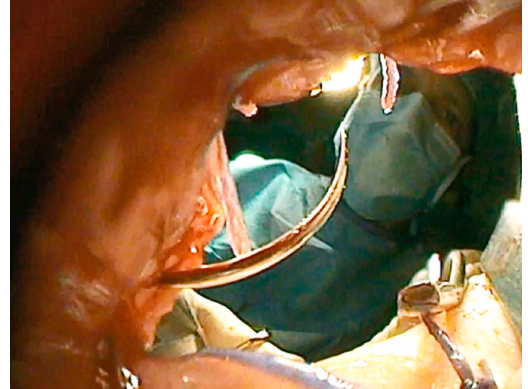
Figure 4. Screenshot of Video S2. Trans-neoanal endoscopic view of the anastomosis being con-structed. Figure 4 . Screenshot of Video S2. Trans ‐ neoanal endoscopic view of the anastomosis be ‐ ing constructed